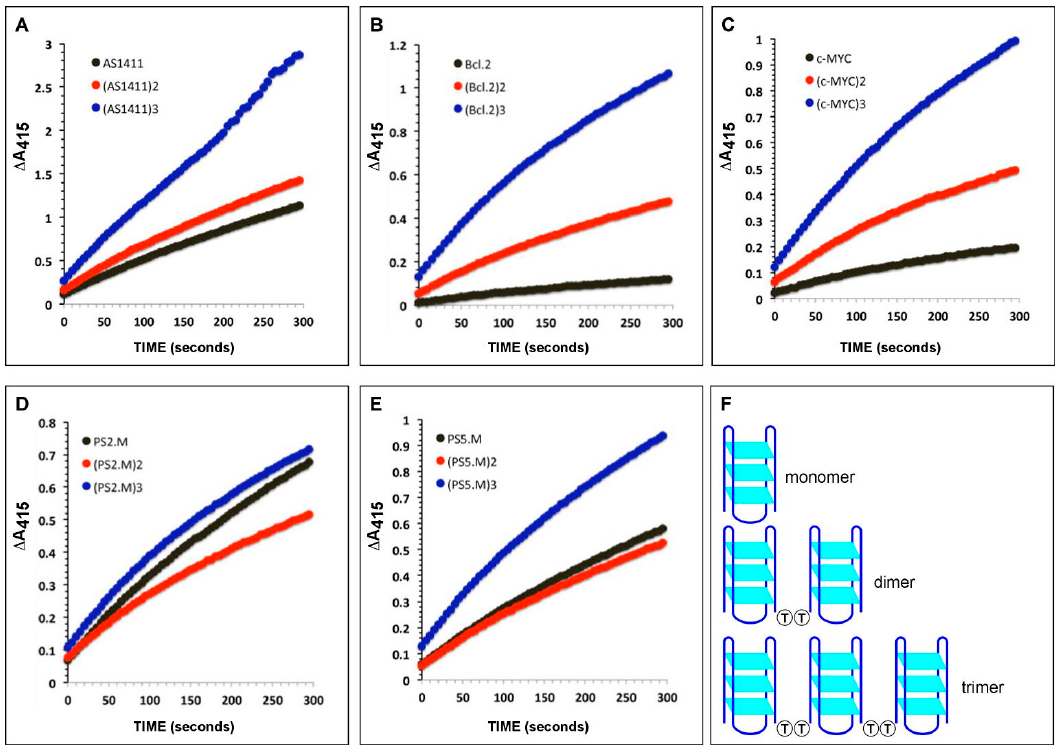
Figure 2. Time course of DNAzyme-catalysed reaction between H 2 O 2 and ABTS ( A ) AS1411 and multimers; ( B ) Bcl-2 and multimers; ( C ) c-MYC and multimers; ( D ) PS5.M and multimers, ( E ) PS2.M and multimers. The numerals 2 and 3 behind each DNAzyme name refer to dimer and trimer respectively e.g., (AS1411)2 and (AS1411)3. Reactions were carried out in 25 mM HEPES-NaOH pH 7.4, 20 mM KCl, 200 mM NaCl, 0.05% Triton X-100, 1% DMSO. The activities of 0.25 µ M DNAzyme were assayed using ABTS (2.5 mM) and H 2 O 2 (0.425 mM). Each reaction was started by the addition of H 2 O 2 , and change in A 415 was monitored immediately after starting the reaction for 5 min. The absorbance values shown were zeroed with those obtained in reactions that did not include the DNAzyme. Each trace is representative of three di ff erent reactions. ( F ) Schematic illustration of the design of G-quadruplex DNAzyme dimers and trimers. In the multimers, each monomeric unit is joined to the next by a TT